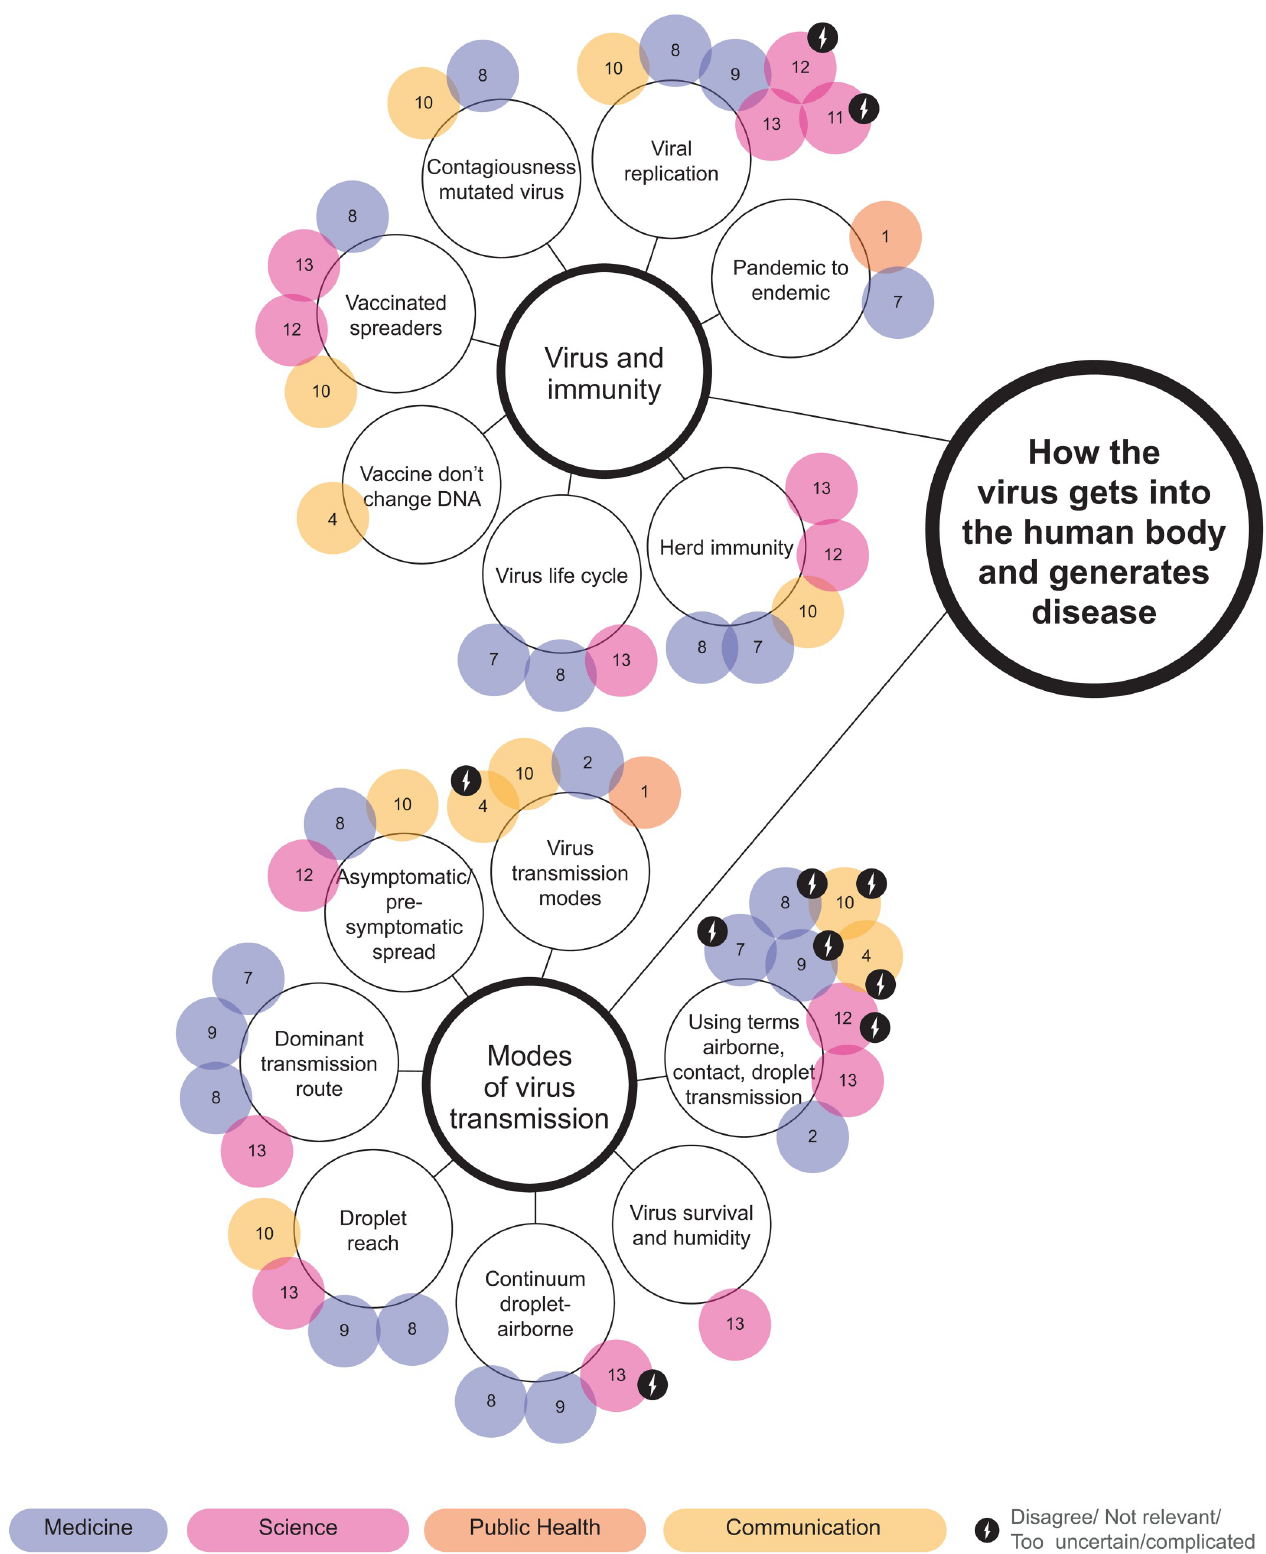
Fig 1. Bubble chart representation of information relating to the theme ‘How the virus gets into the human body and generates disease’.